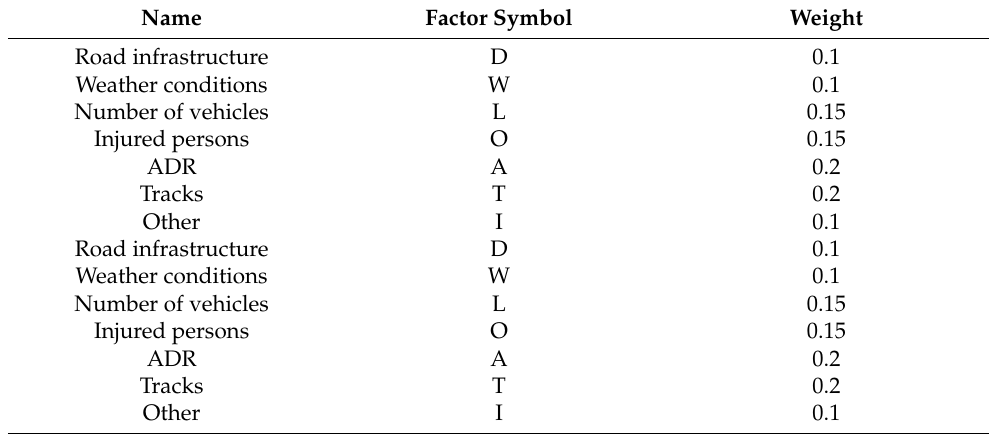
Table 4. Main factors and their weights.